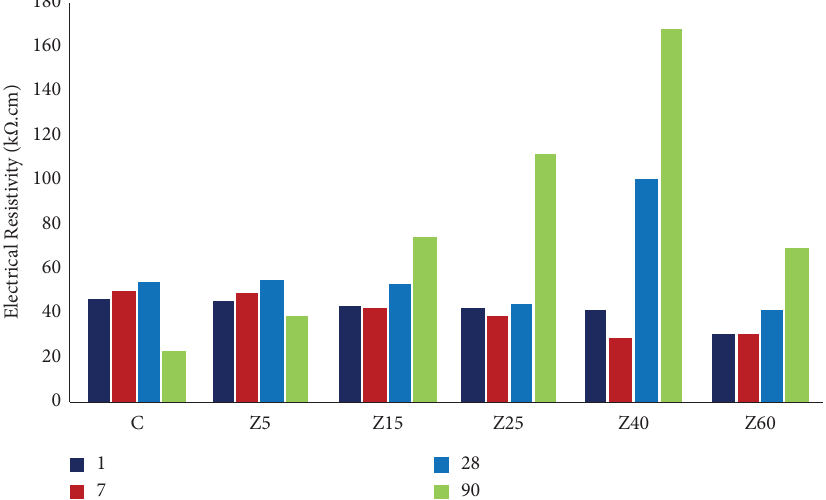
Figure 12: Electrical resistivity values of the zeolite mixtures.